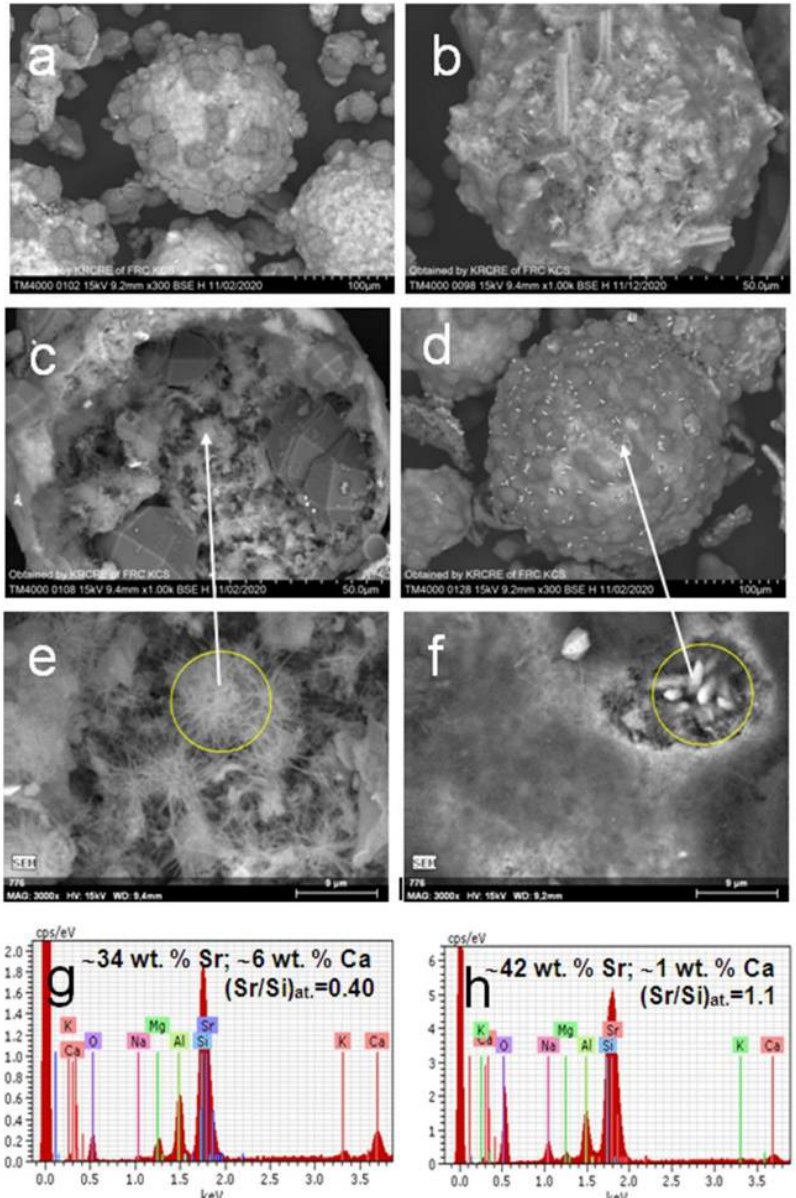
Figure 4. SEM images of ( a–d ) product particles resulting from hydrothermal crystallization in the Sr(NO 3 ) 2 -NaOH-H 2 O-(SiO 2 -Al 2 O 3 ) glass systems at 200 °C; ( e , f ) BSE micrographs and ( g , h ) associated EDX spectra for local parts of the particles.